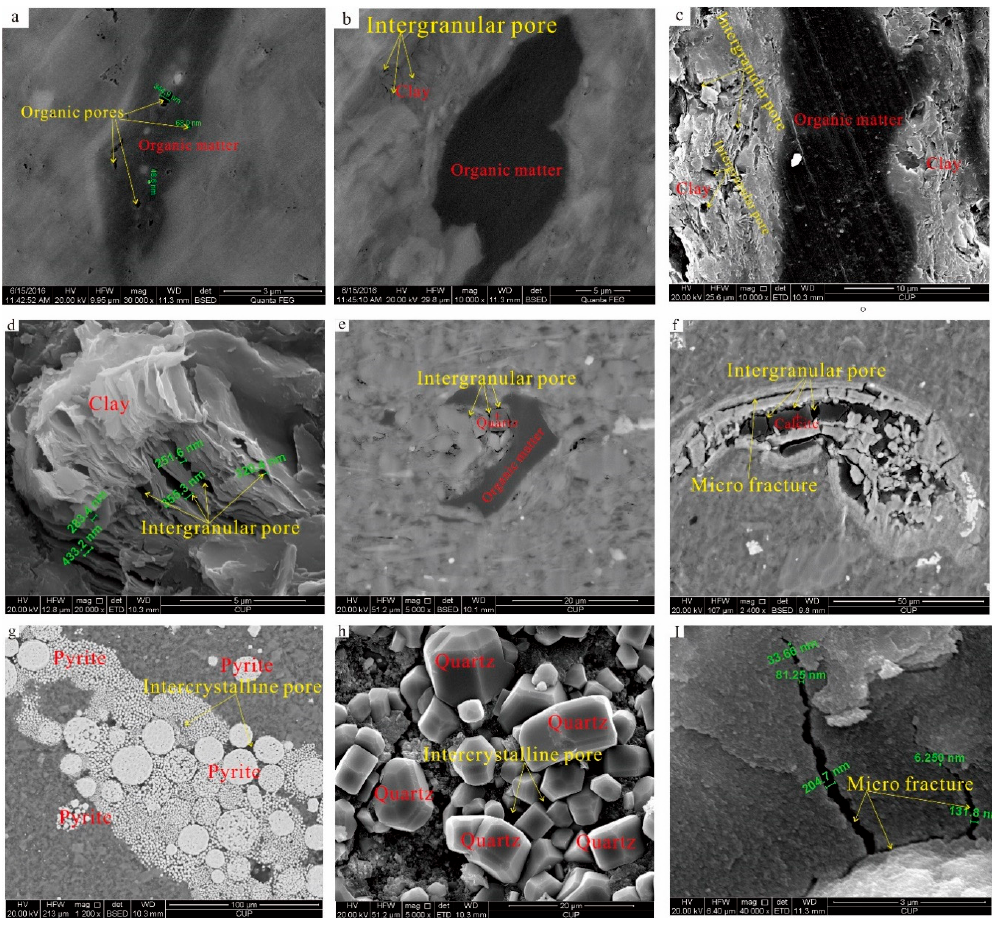
Figure 3. FE-SEM images of the Yanchang shale samples. ( a ) Organic matter with fewer pores; ( b ) rudimentary intergranular pores between clay minerals; ( c ) developed intergranular pores between organic matter and clay minerals; ( d ) unpolished with argon ion, intergranular pores in the clay minerals; ( e ) intergranular pores between quartz grains and organic matter; ( f ) intergranular pores and micro fracture in the calcites; ( g ) intercrystallite pores in the primary pyrite framboids; ( h ) unpolished with argon ion, intercrystallite pores in the quartz grains; ( i ) micro fractures in the mineral grains. Minerals 2019 , 9 , x FOR PEER REVIEW